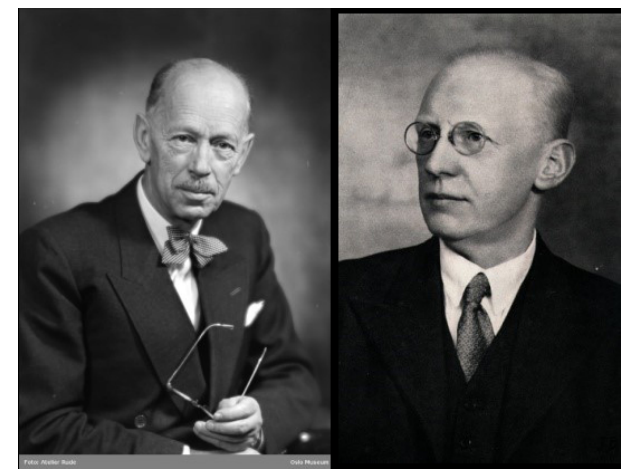
Figure 3. Professors Harald Sverdrup (source: https: //digitaltmuseum.org/011014857601/harald-sverdrup/media? slide=0, last access: 19 March 2019) and Joseph Proudman (source: http://www.tide-and-time.uk/local-heroes-joseph-proudman, last access: 19 March